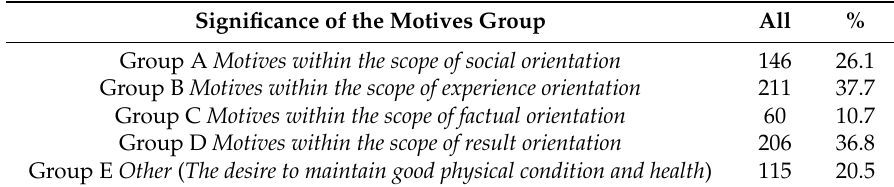
Table 5. Significance of particular groups of motives covered by the research ( n =